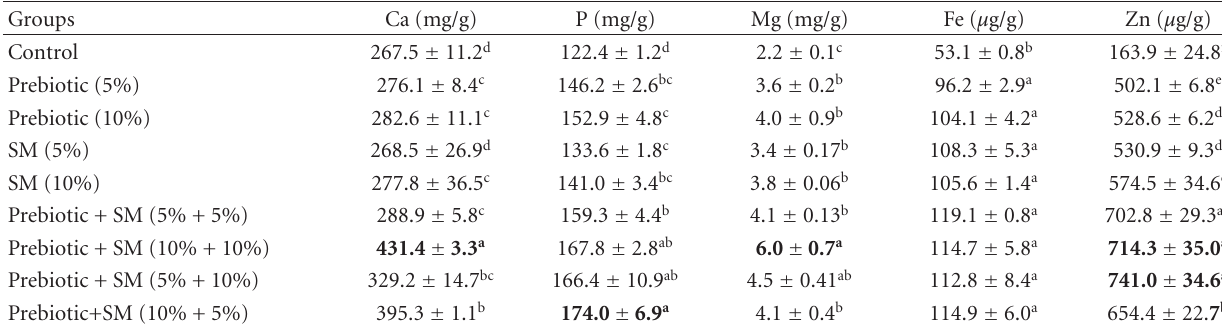
Table 4: E ff ect of prebiotic and soybean meal on bone